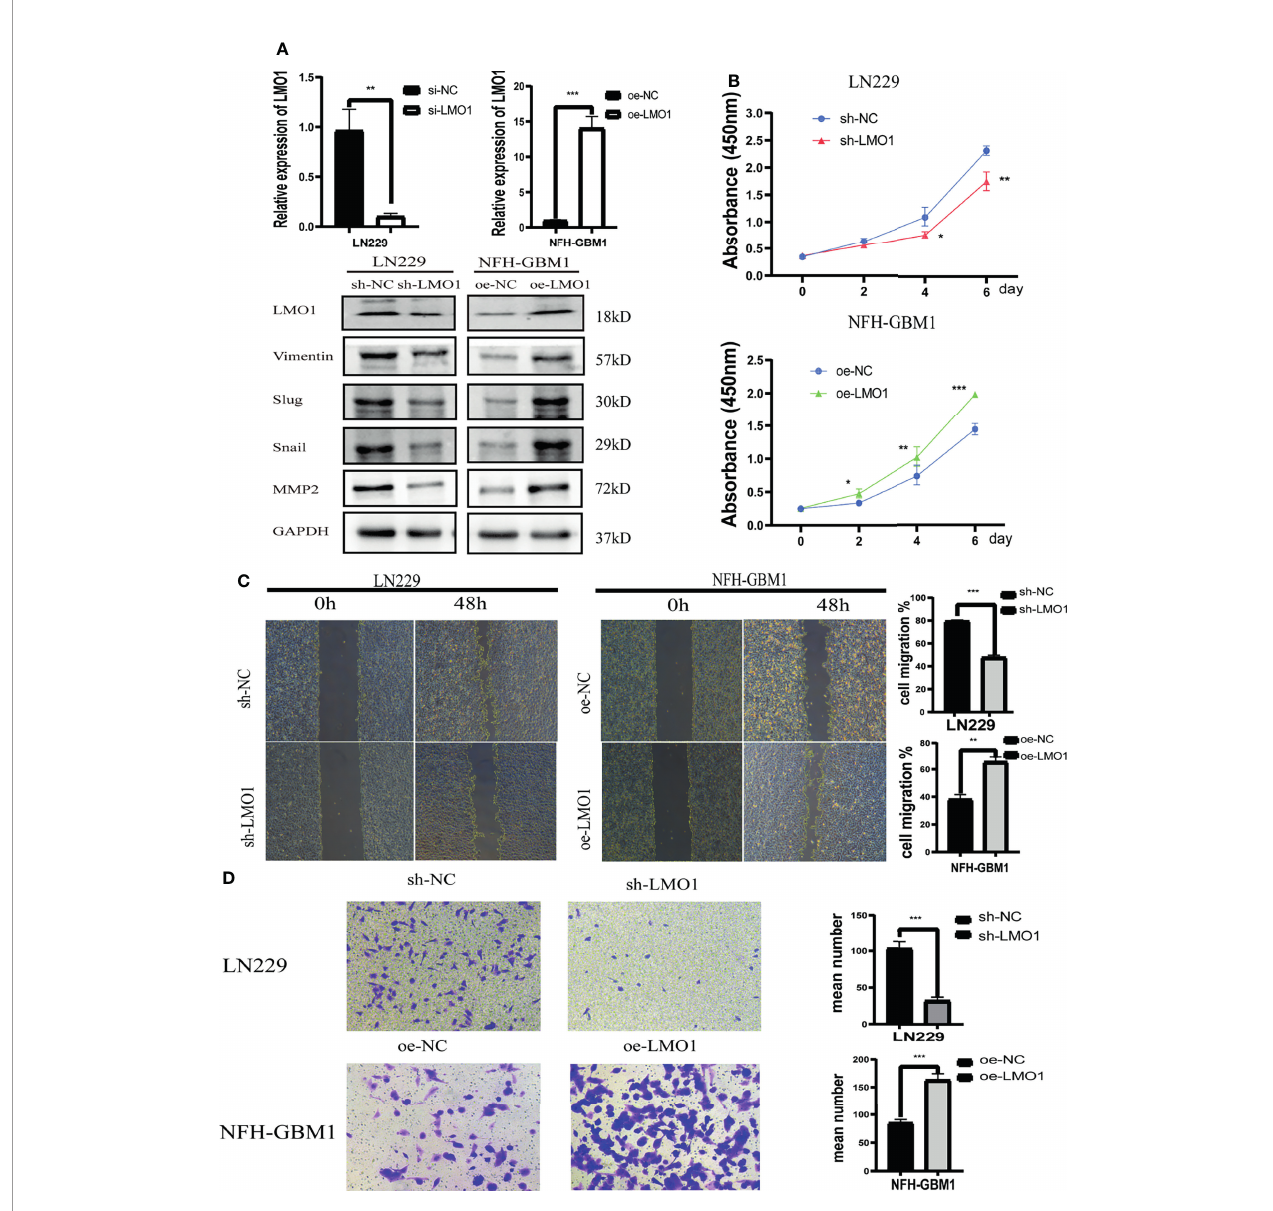
FIGURE 3 | In vitro assays revealed that LMO1 is essential for glioma tumorigenesis and progression. (A) qPCR and WB analysis of LMO1 in LN229 cells or NFH- GBM1cells after the indicated shRNA or overexpression transfection. GAPDH was used for normalization. Unpaired Student ’ s t-tests was used for statistical analysis. (B) Cell counts of surviving LN229 cells and NFH-GBM1cells 6 days after the indicated transfection. Six technical replicates were performed for each group. One- way ANOVA was used for statistical analysis. (C) Scratch assays of LN229 cells and NFH-GBM1cellsafter transfection. At least fi ve independent fi elds of cells were counted and measured. Three biological replicates were performed. Student ’ s t test was used for statistical analysis. (D) Transwell assays of LN229 cells and NFH- GBM1cell after transfection. Original magni fi cation, 400×. Five random fi elds of view were captured for each group. Three biological replicates were performed(left panel). Quanti fi cation of transwell assay is shown in the right panel. Student ’ s t test was used for statistical analysis. *p < 0.05. **p < 0.01. ***p <